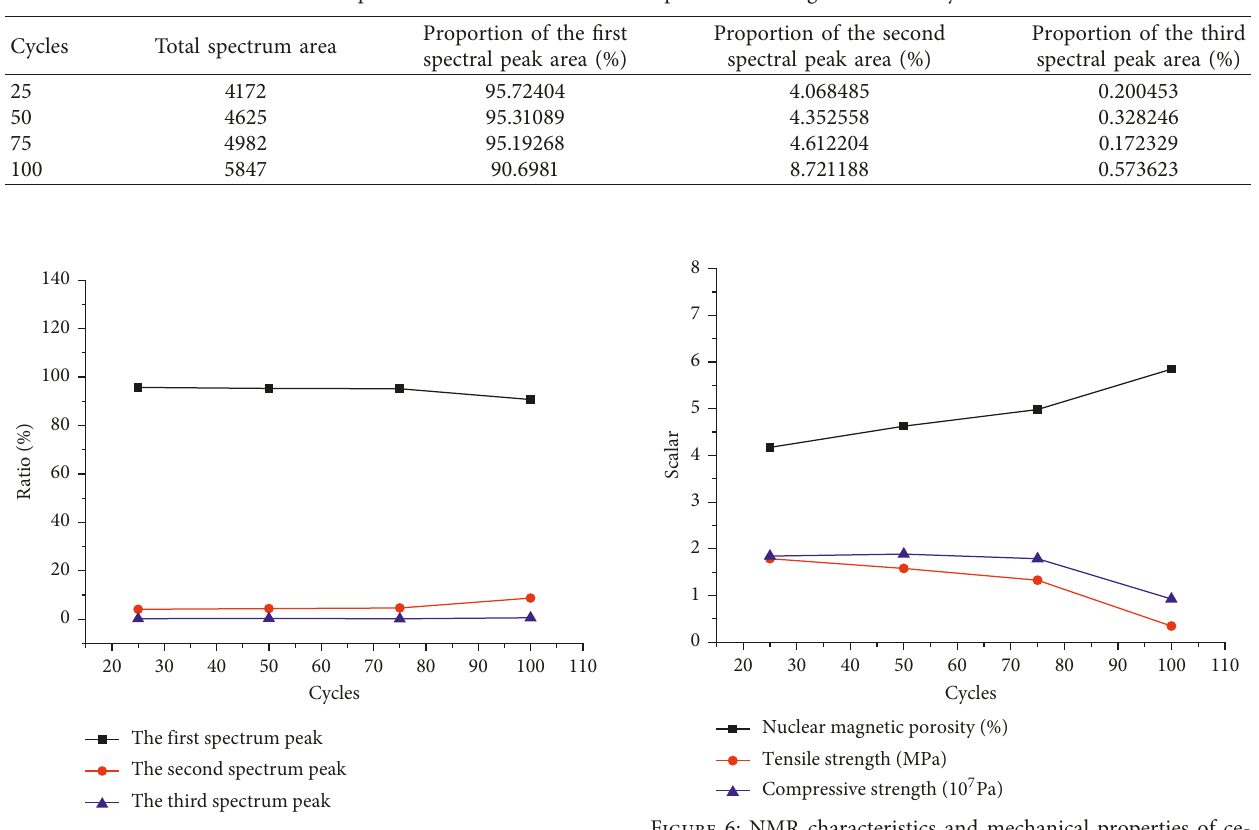
Figure 5: Ratio change rule of each spectrum peak in the T spectrum.